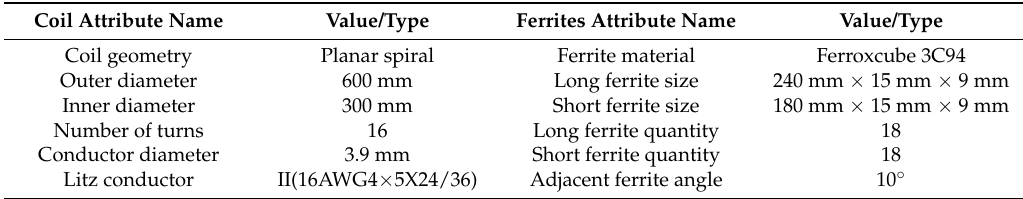
Table 2. Parameters of coils and ferrites.